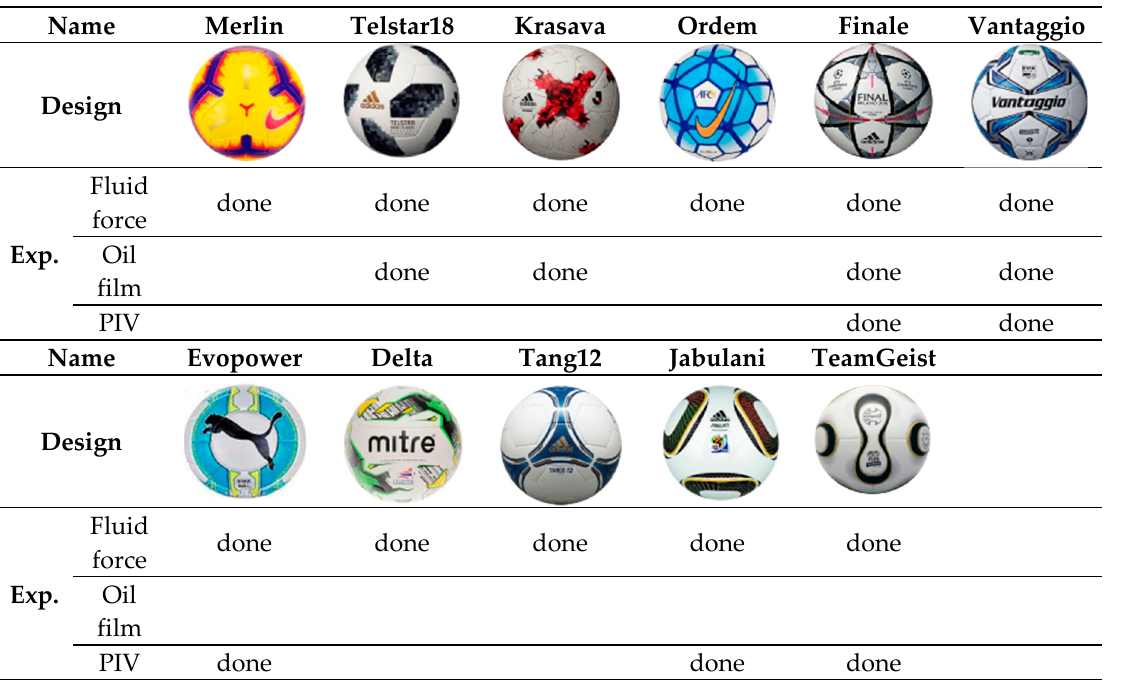
Table 1. Balls used in the experiment and the experiment